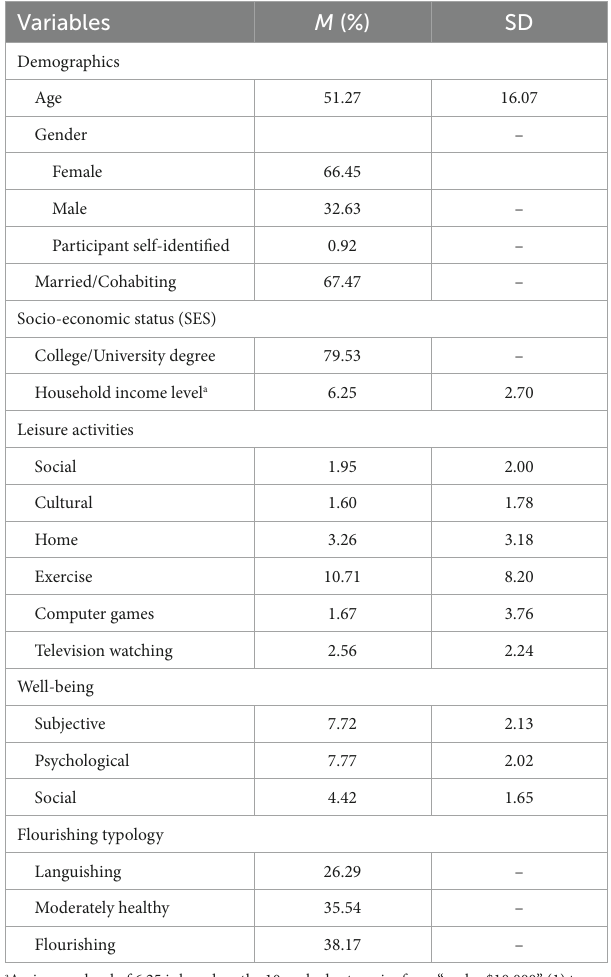
TABLE 1 Means and percentages of demographics, socioeconomic status, leisure activities, wellbeing, and flourishing typology.